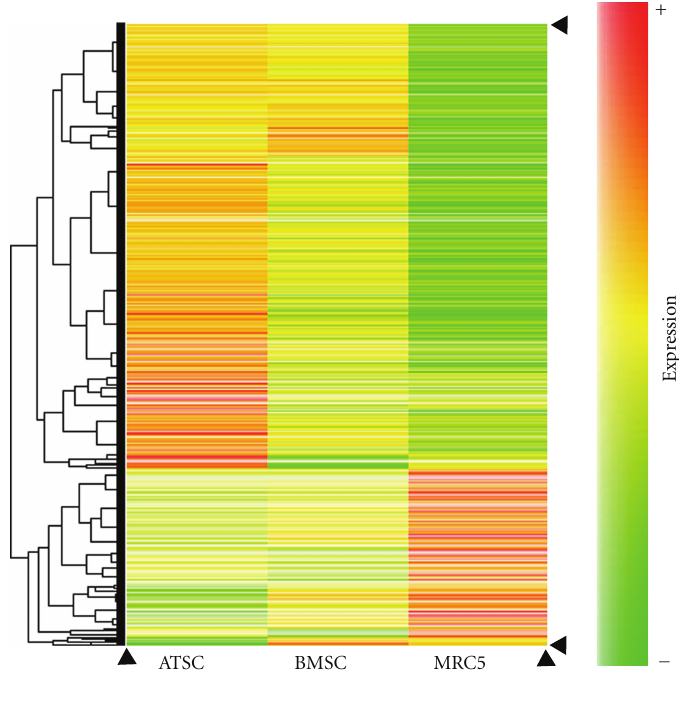
Figure 1: Hierarchical clustering of microarray data. The dendrogram shows all the 441 genes di ff erentially expressed in ATSC (selected by t -test, P value 0.01) resulting from the statistical analysis [3]. Each row represents a single gene, while cell types are grouped in columns. The colored representation of gene expression is shown according to the scale on the right side of the figure. BMSC: bone-marrow-derived stromal cells; MRC5: human lung fibroblast cell line. See [3] for